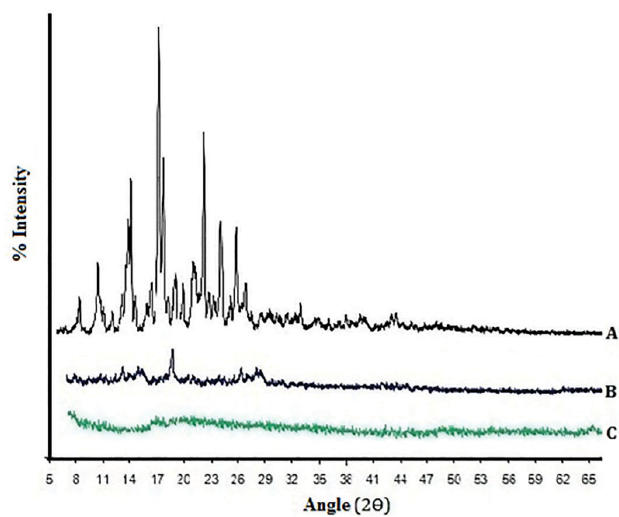
FIGURE 7 - X-ray powder diffractometry of (A) pure sertraline, (B) physical mixture, and (C) solid